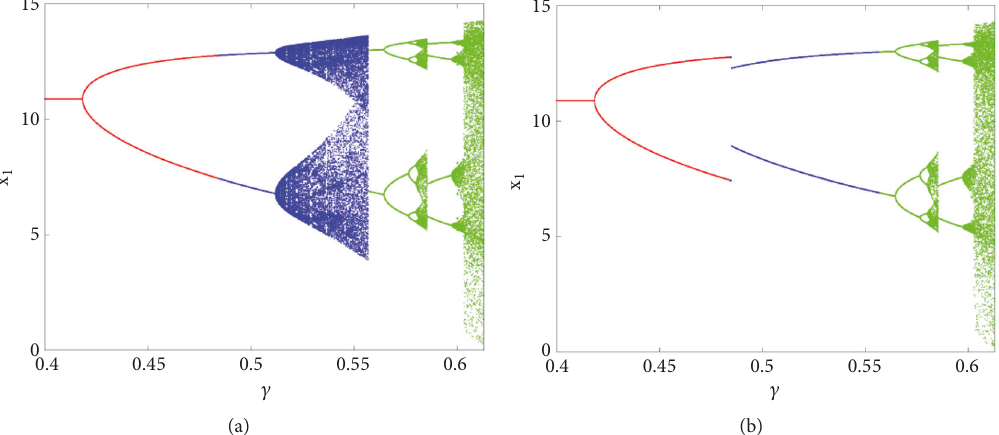
Figure 7: The one-parameter bifurcation diagram with 𝑎 = 7.12 , 𝑏 = 0.024 , 𝑐 = 0.98 , 𝛽 = 0.38 , 𝛾 = 0.44 , and 𝛼 1 = 𝛼 2 = 𝛼 . (a) The one- parameter bifurcation diagram in relation to 𝛼 with initial conditions (𝑥 1 , 𝑥 2 ) = (2.33,1.3) ; (b) The one-parameter bifurcation diagram in relation to 𝛼 with initial conditions (𝑥 1 , 𝑥 2 ) = (2.33,2.3)